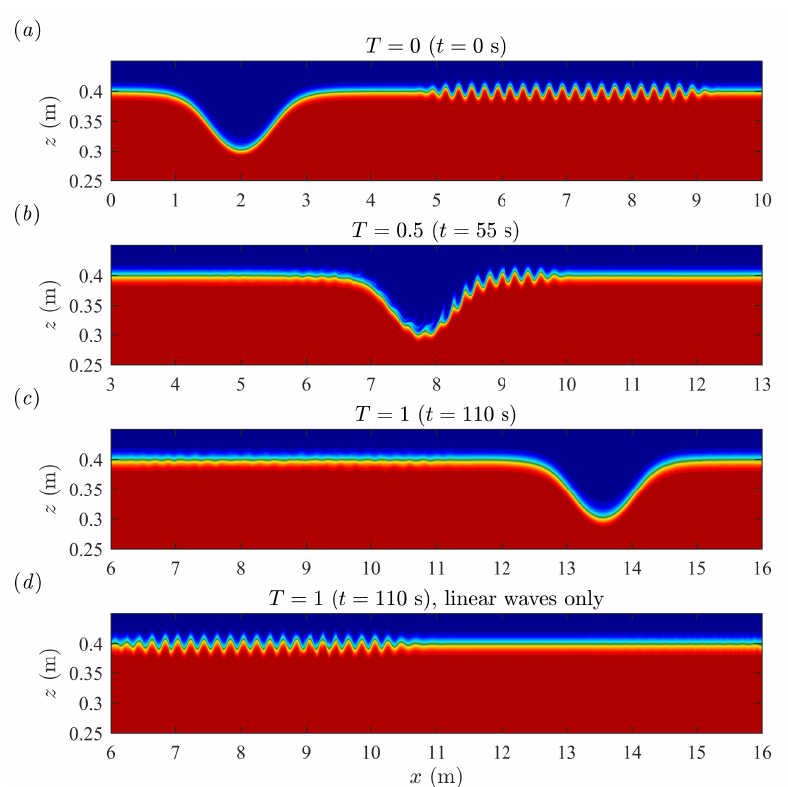
Figure 4. Shaded density contours (full range of density shown, green denotes the pycnocline centre) showing the solitary wave and the linear waves in the case O2 (a) before, (b) during, and (c) after the collision. Panel (d) shows the corresponding density field from the simulation performed with the same linear wave packet but without the solitary wave. Note the difference in x axis for each